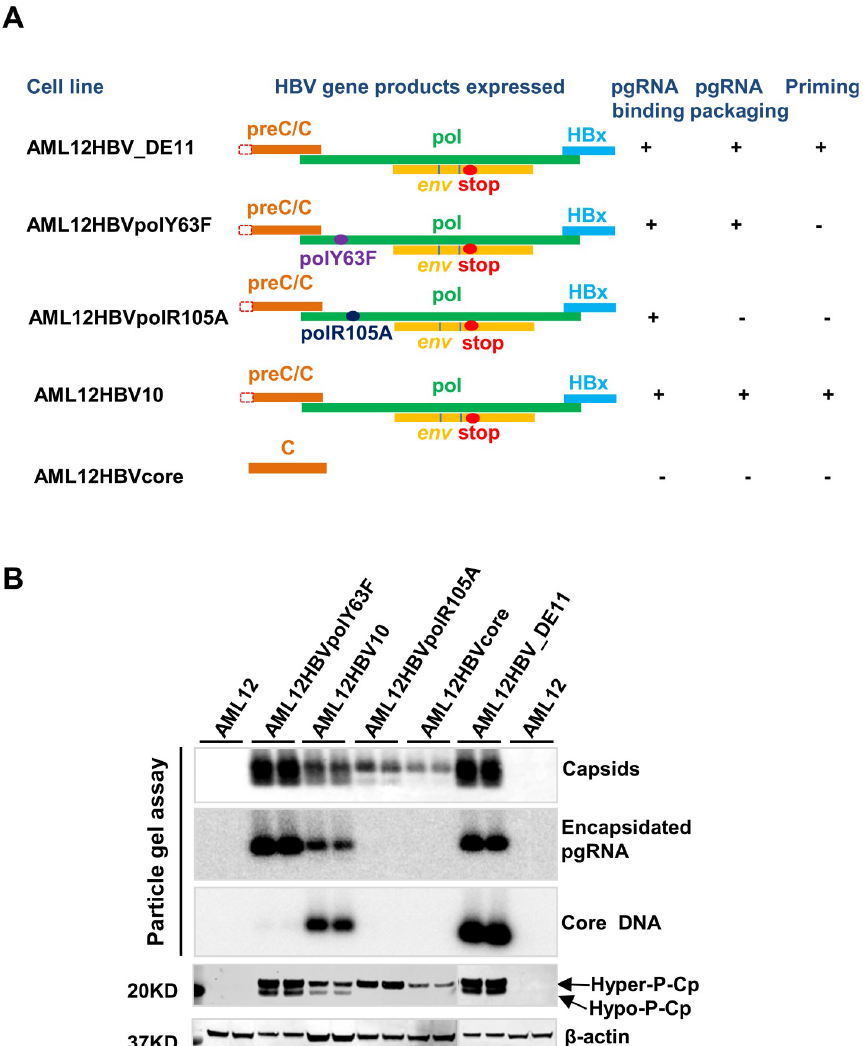
Fig 1. HBV Cp dephosphorylation is associated with pgRNA packaging. (A) AML12-derived stable cells with integrated HBV transgene that tet-off inducible expression HBV pgRNA or Cp ORF. The mutation(s) in each of the transgenes are highlighted. The biological property of the transgene-encoded polymerase, including the ability to support pgRNA-binding, pgRNA packaging and DNA synthesis, are indicated. (B) All the cell lines were cultured in the absence of tet for 3 days. Intracellular HBV capsids were resolved by electrophoresis in 1.8% native agarose gel and transferred on a Nylon membrane. HBV capsids were probed by a rabbit polyclonal antibody against HBV Cp (Dako). The encapsidated pgRNA and core DNA were detected by hybridization with an α - 32 P-UTP labeled full-length negative-strand and positive-strand HBV RNA probe, respectively. HBV Cp expression and phosphorylation status were determined by a Western blot assay with antibody HBc170A. β -actin served as a loading